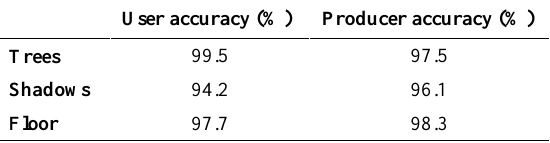
Table 3: The user accuracy and producer accuracy of the canopy cover